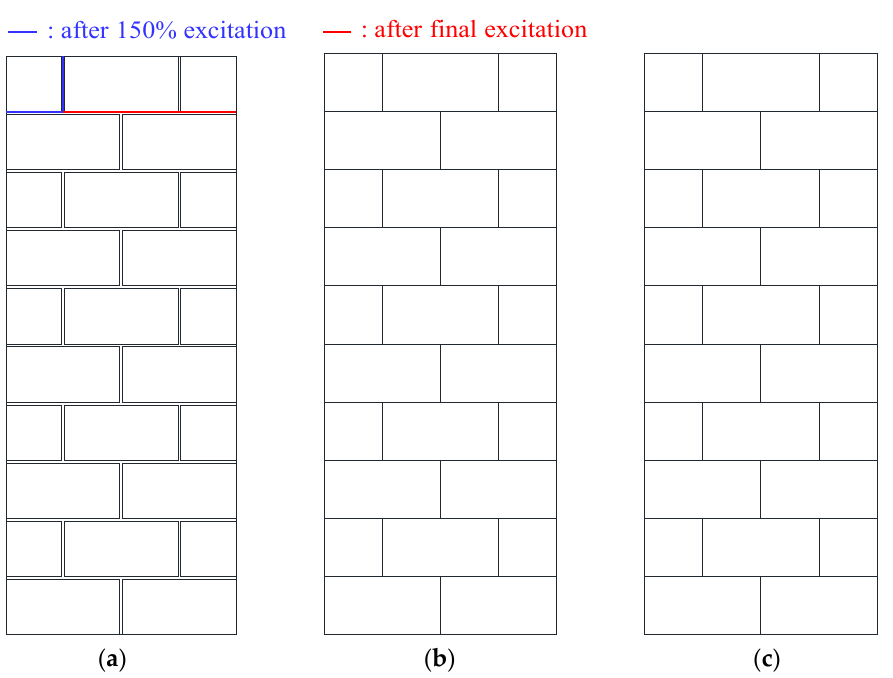
Figure 14. Final failure patterns: ( a ) Specimen CB; ( b ) Specimen HS; ( c ) Specimen PS.